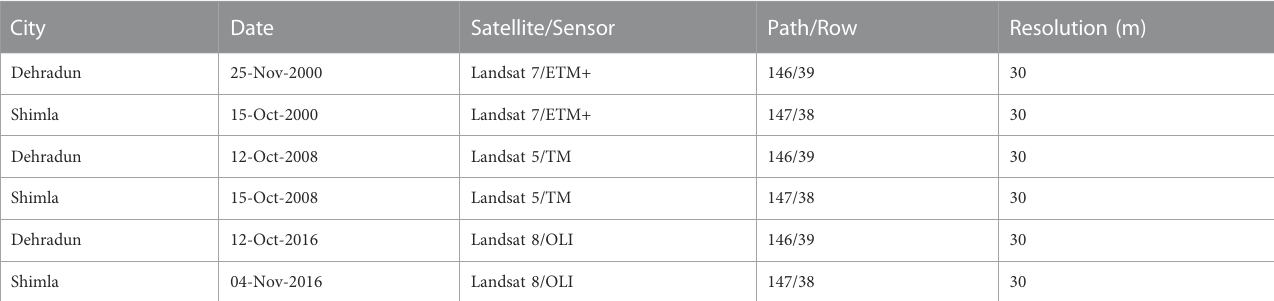
TABLE 1 List of cities with speci fi cations of satellite